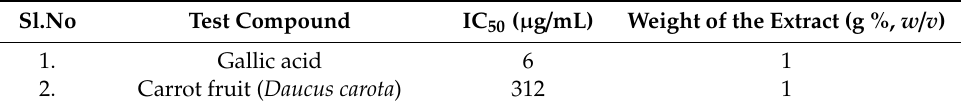
Table 1. Antioxidant activity of Daucus